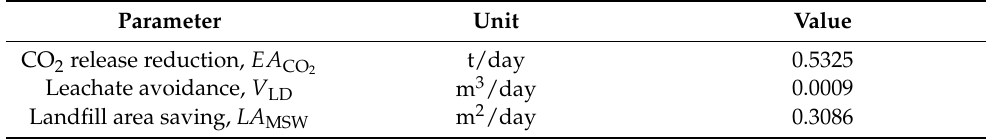
Table 2. Contribution to environmental